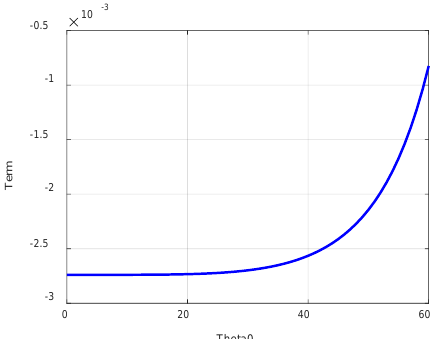
Figure 2. The mapping from θ 0 to Term ( t m )